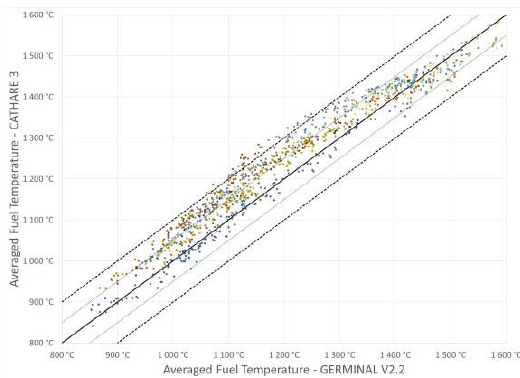
Figure 3 : Volume Power Map – Nominal State - Adiabatic Kinetic CATHARE-MINARET